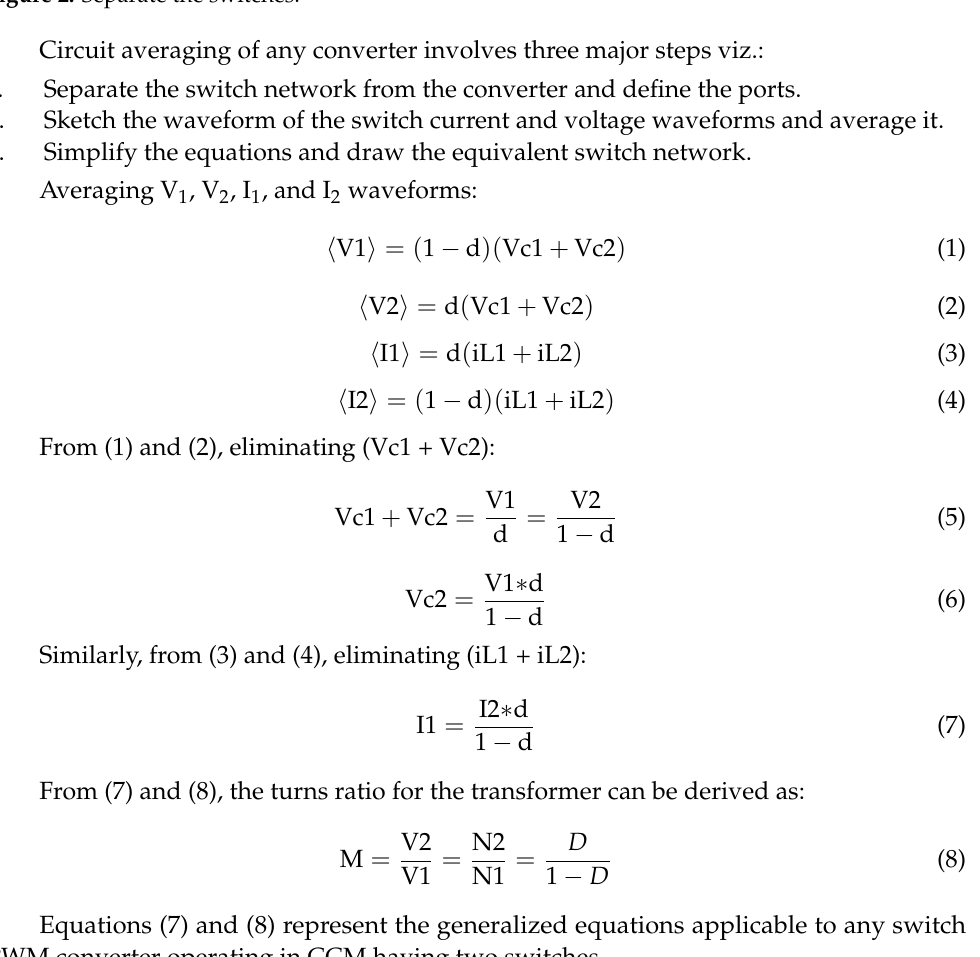
Figure 2. Separate the switches.